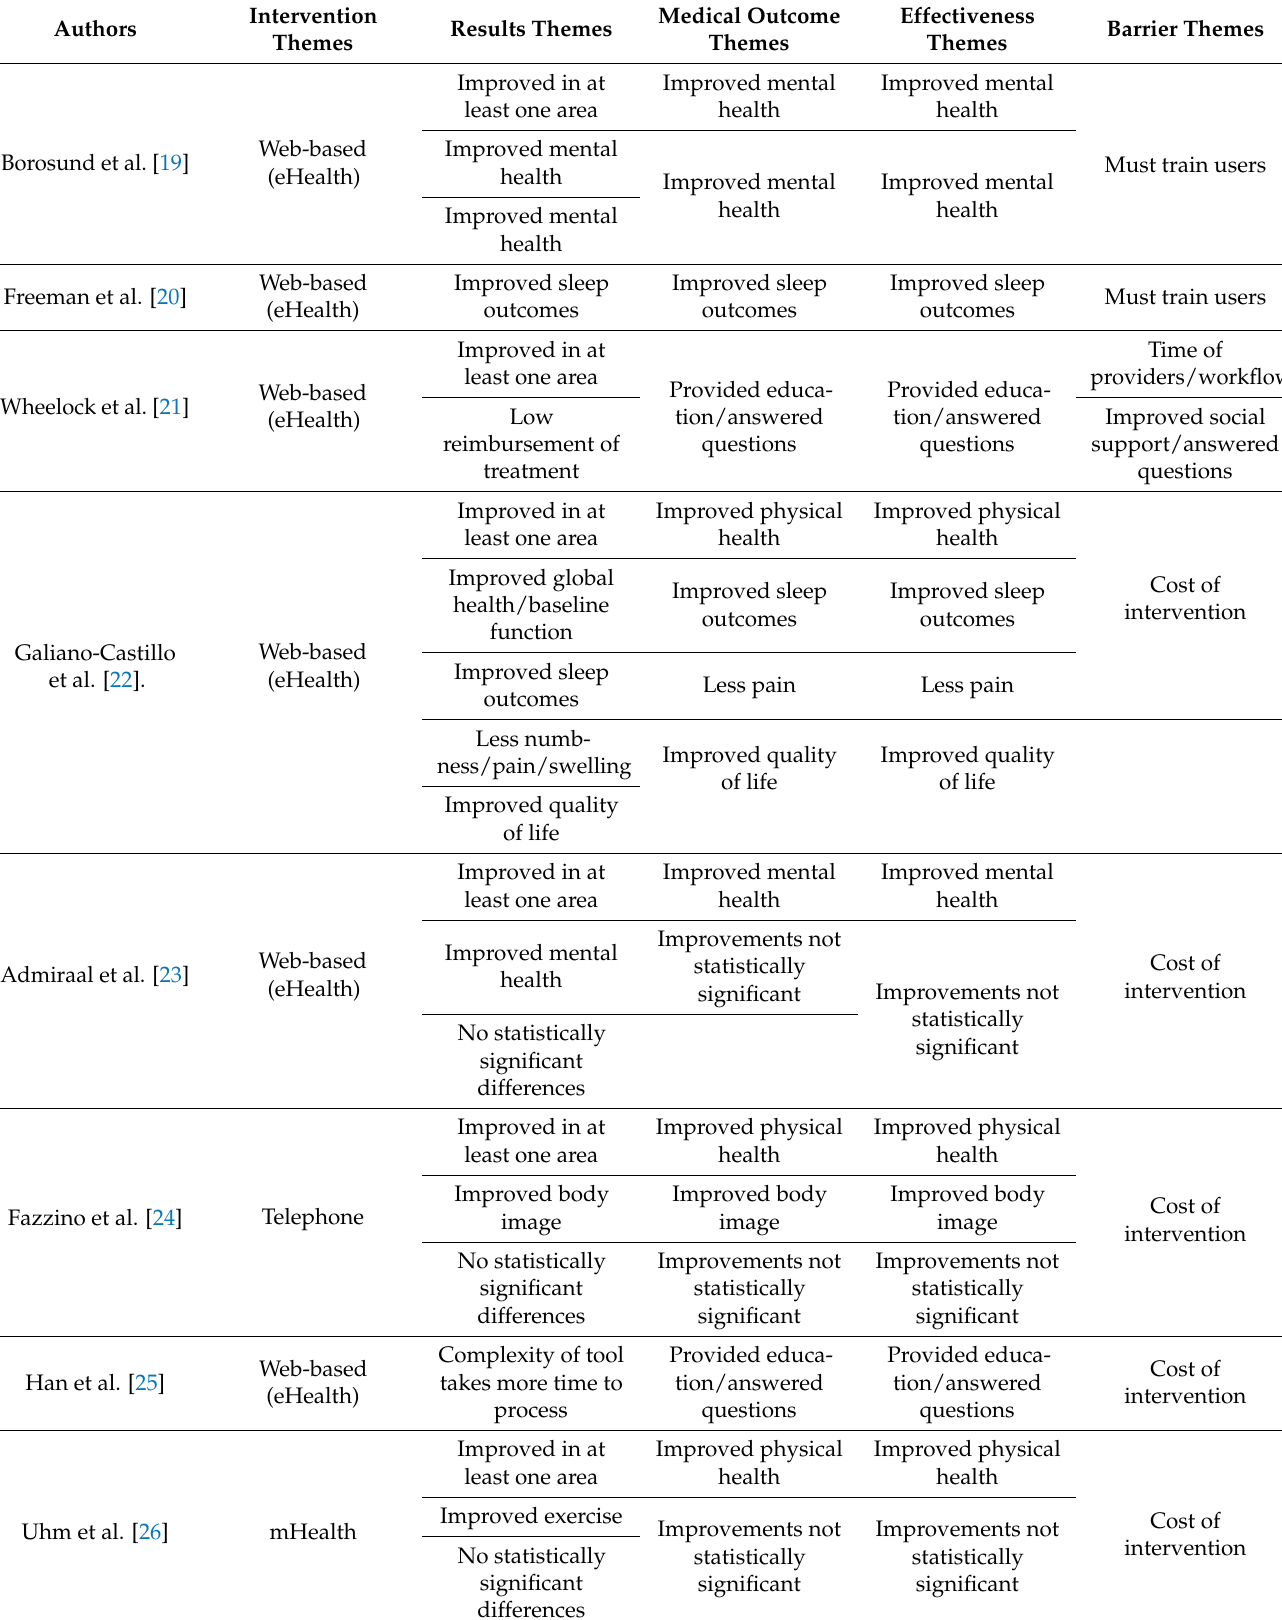
Table 2. Summary of analysis, sorted